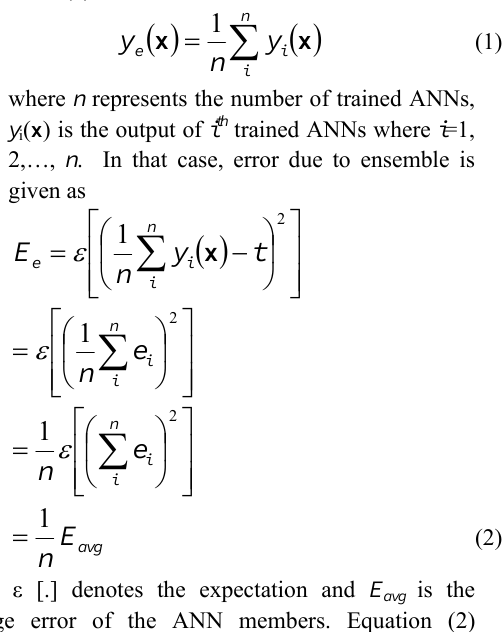
Fig. 11 An ensemble of n numbers of trained ANNs The effectiveness of the formed ensembles depends on how these models are chosen ((Ed.), 1999). In reference to the Fig. 11, which shows an ensemble of n numbers of trained ANNs, let the output ( y e ) of the ensemble is taken as the average of the ANN members’ outputs as expressed in (1).